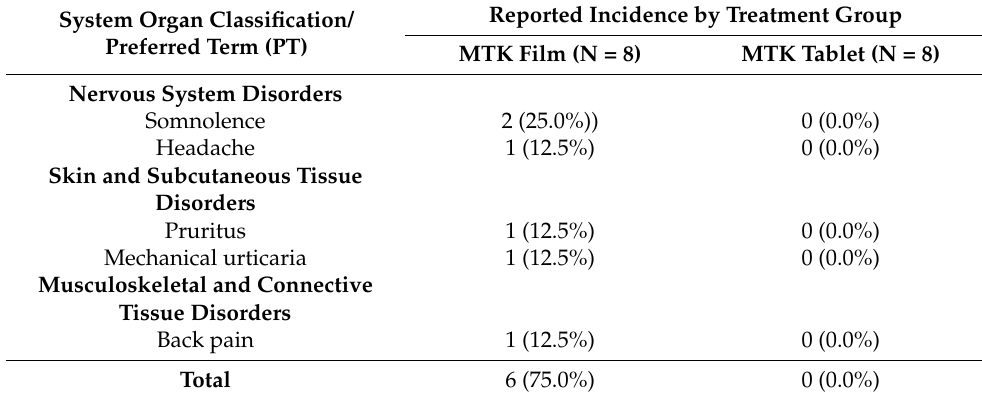
Table 6. Adverse events reported during the study.